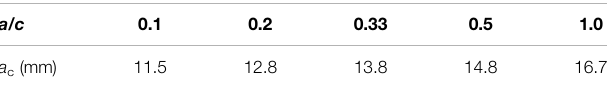
TABLE 3 | Acceptable underclad semi-elliptical crack depths with the allowable residual life of 2